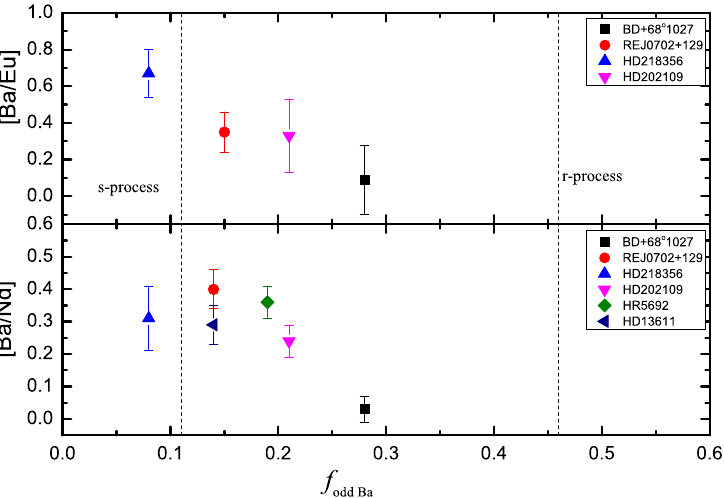
Figure 7. Top panel: the abundance ratio [Ba/Eu] vs. f odd,Ba ; bottom panel: [Ba/Nd] vs. f odd,Ba . The two dotted lines represent f odd,Ba = 0.11 (the solar pure s-process) and f odd,Ba = 0.46 (the solar pure r-process) from Arlandini et al.